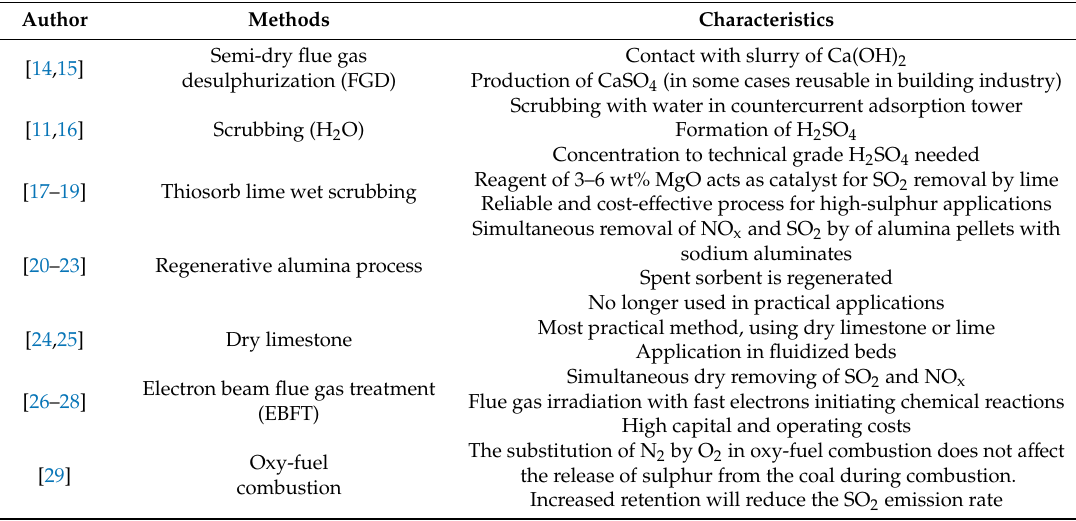
Table 2. Relevant literature findings for end-of-pipe